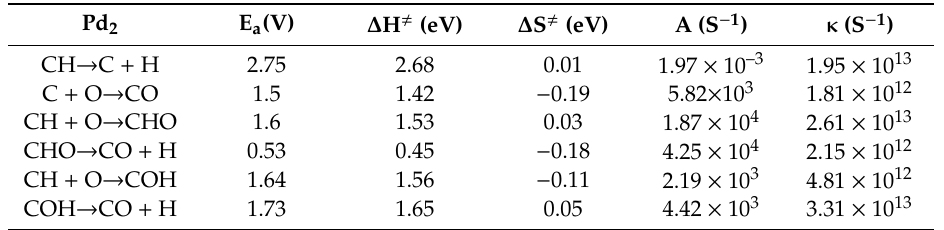
Table 6. The activation energy (E a ), di ff erence enthalpy between the transition state and the initial state ( ∆ H (cid:44) ), di ff erence entropies between the transition state and the initial state ( ∆ S (cid:44) ), pre-exponential factor (A), rate constant ( κ ) for methane activation on Pd 2. Pd 2